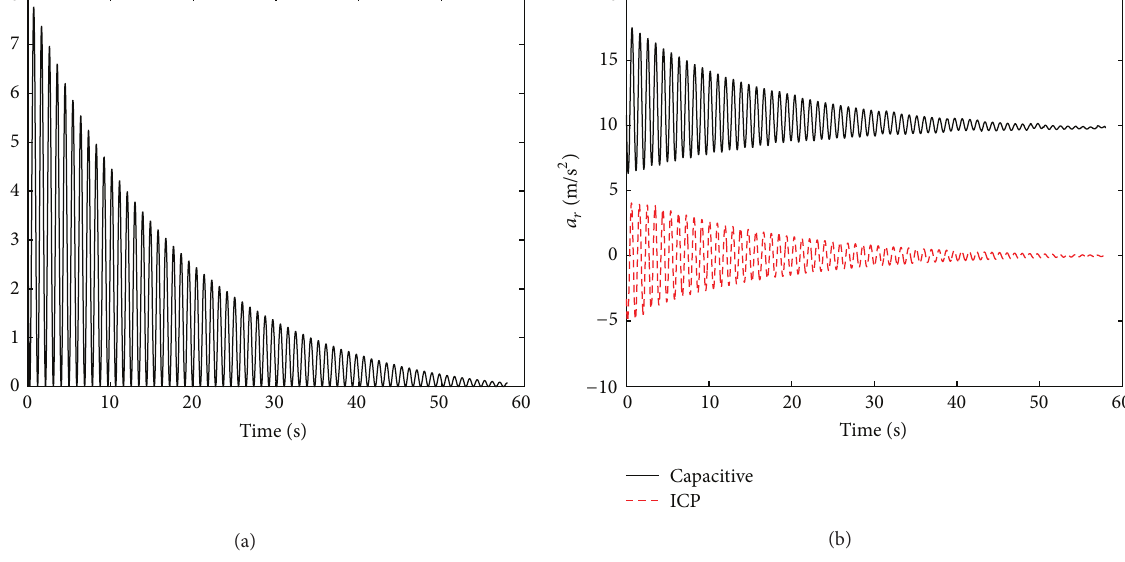
behaviour. A “cleaning” operation can be thought of as